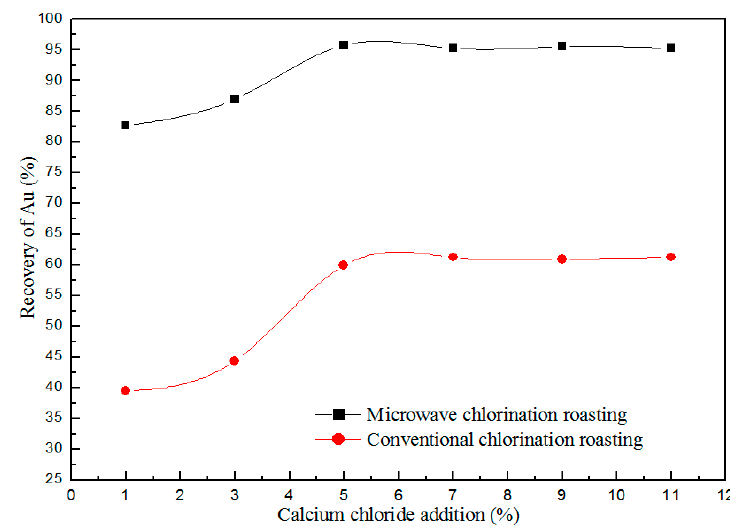
Figure 5. Effect of calcium chloride with different additions on the recovery of Au.